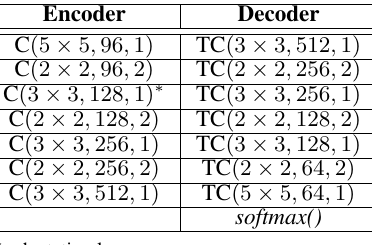
Table 2. Network Architecture; ( w × w, k, s ) denotes (kernel size, number of kernels,